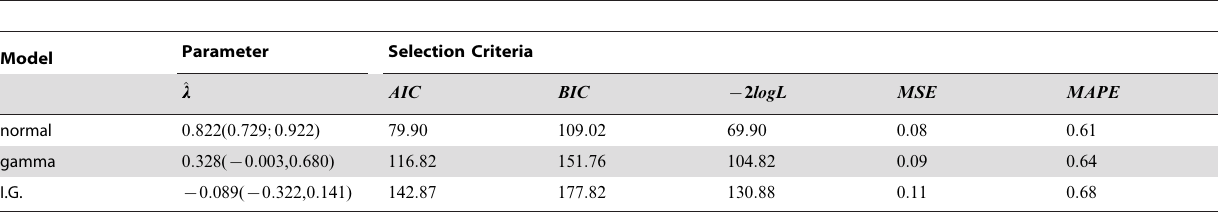
Table 3. Selection criteria for the GSAMs fitted with ^ ll adjusted according to the likelihood method.